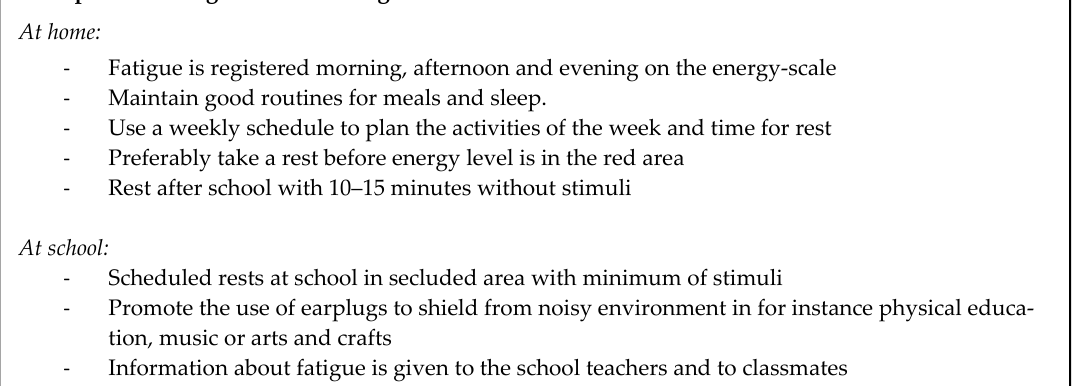
Figure 2. An example of the “The goal staircase”. This example shows a goal related to fatigue and how fatigue was operationalized as energy on a scale. Energy level is measured three times each day. Strategies to obtain the goal are presented in the textbox.